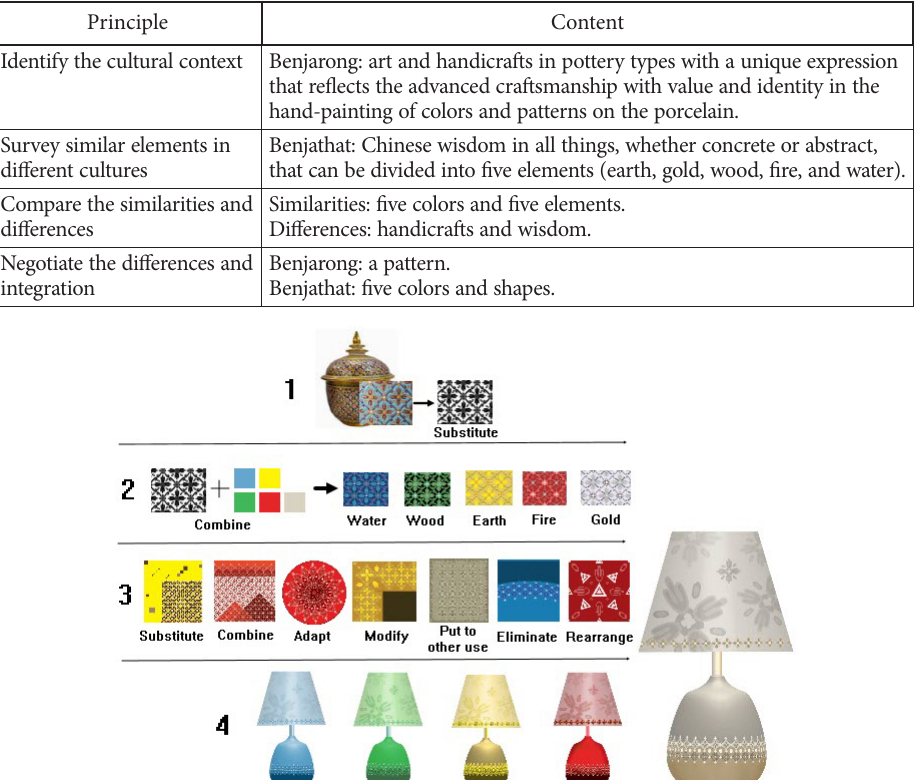
Figure 1. The application of SCAMPER to the cultural products in the bicultural context (source: created by